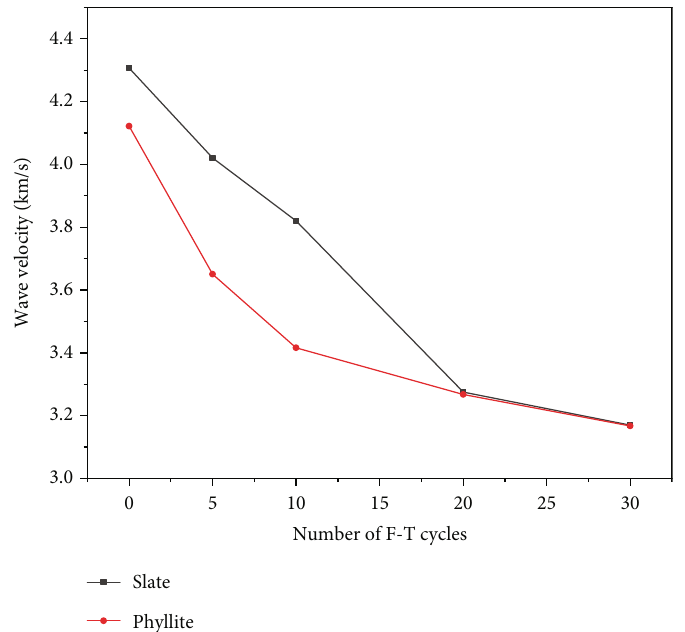
Figure 7: Wave velocity of two samples following freeze-thaw cycles.